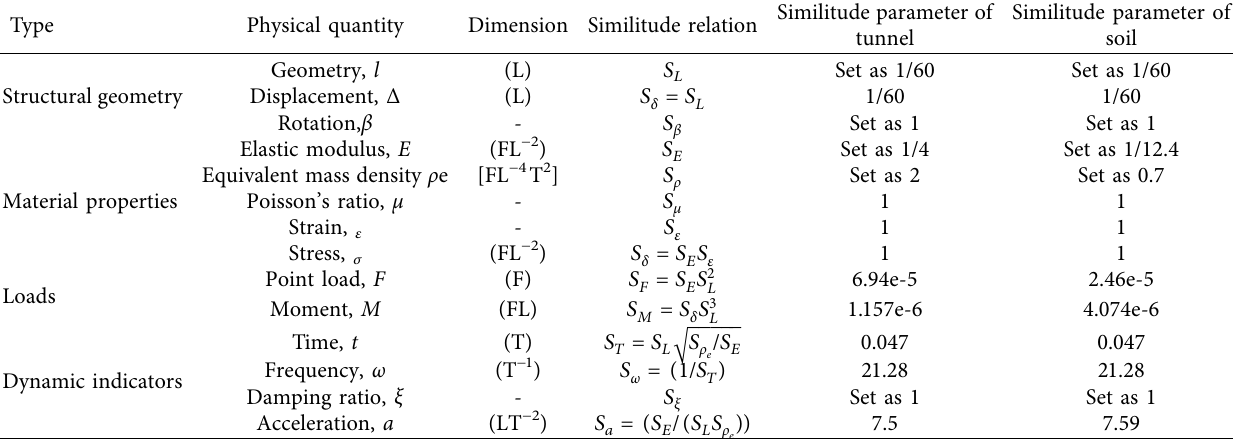
Table 2: Similitude relation of the immersed tunnel model and soil model.